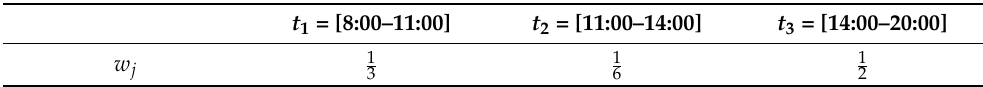
Table 5. Relative weights.